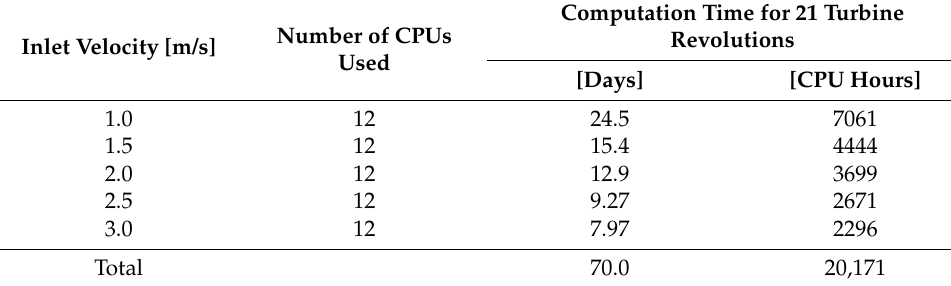
Table 2. Computational cost of each simulation.